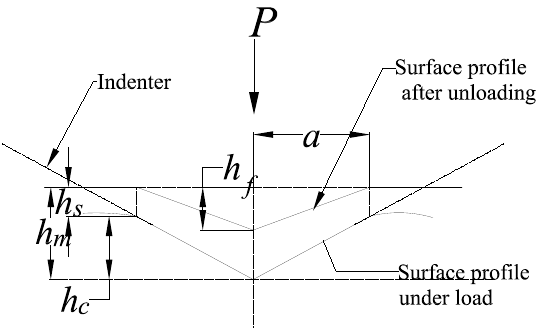
Figure 11. Schematic of indentation deformation at peak load and after unloading.